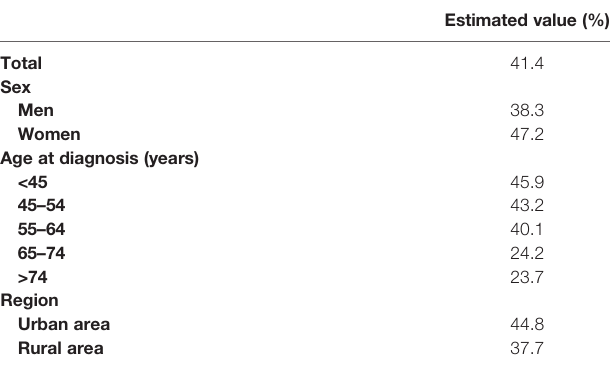
TABLE 3 | Prediction of the survival of liver cancer patients during 2019 – 2023 in Taizhou, eastern